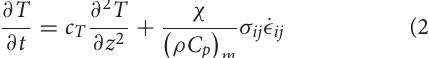
a ) is assumed v 0 , and the radial velocity at point =